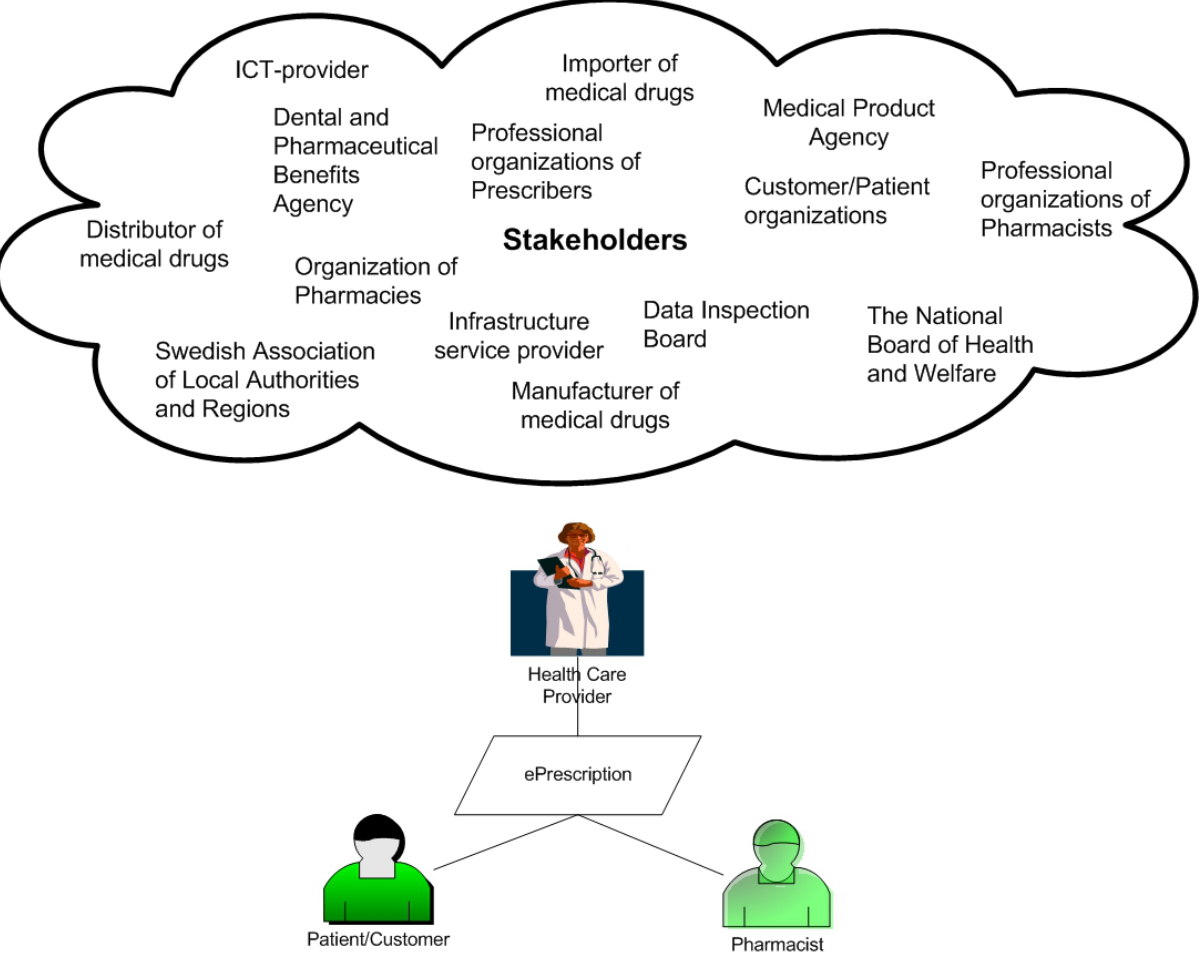
Figure 2. Stakeholders in